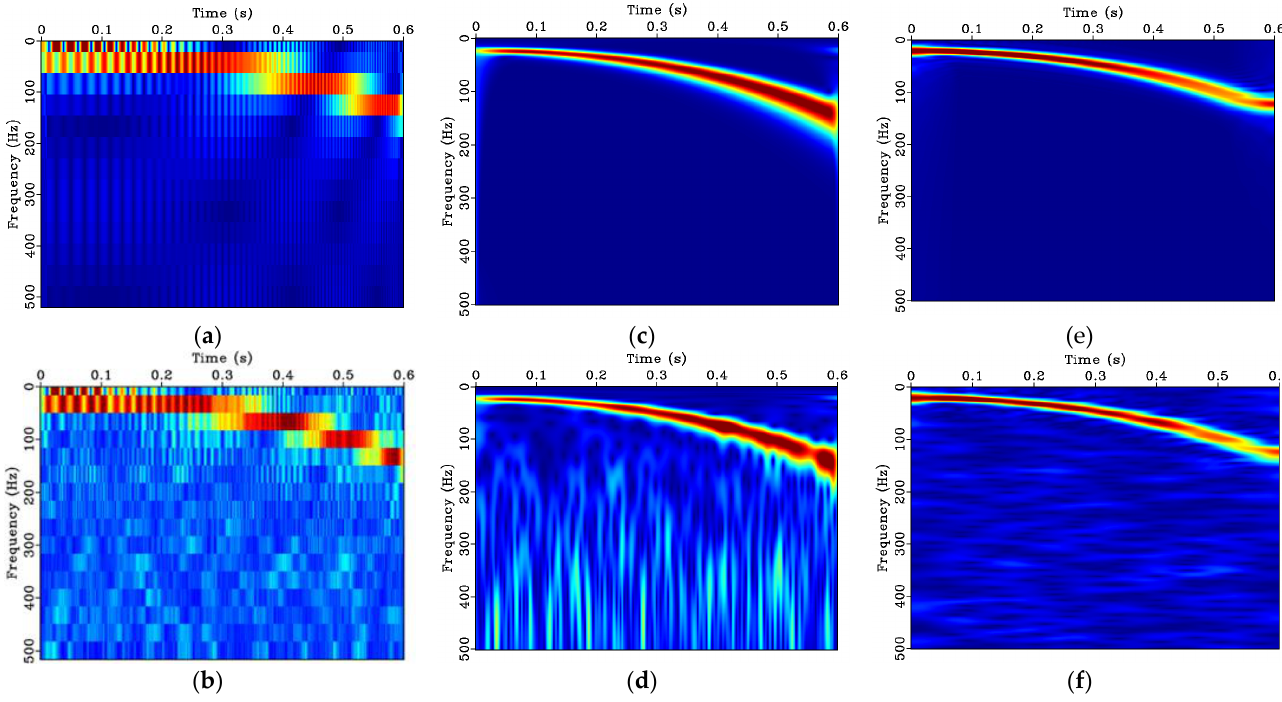
Figure 8. Time-frequency spectrum of the nonlinear frequency-varying signal: ( a ) STFT spectrum; ( b ) STFT spectrum for noisy signal; ( c ) ST spectrum; ( d ) ST spectrum for noisy signal; ( e ) LTFT spectrum; ( f ) LTFT spectrum for noisy signal. The jet colormap is used where blue and red represent low and high frequency magnitudes, respectively.